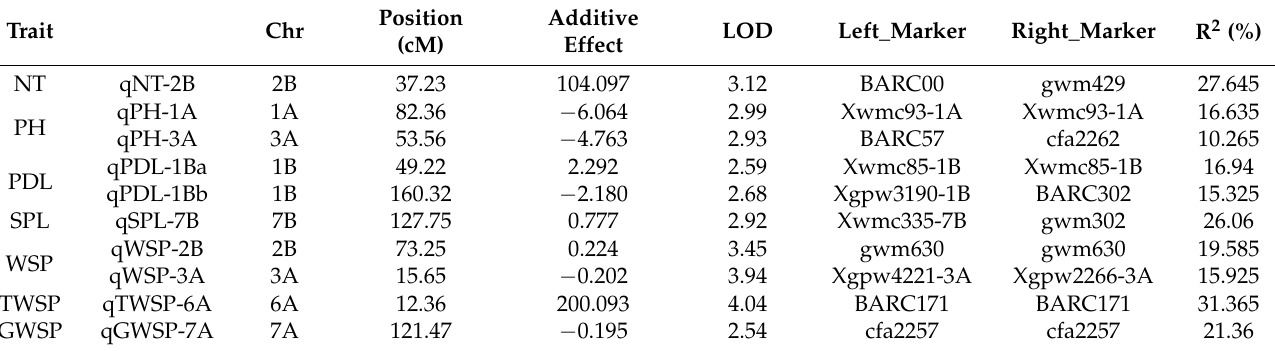
Table 4. QTLs identified using the F8 population derived from Gonbad × Zagros in